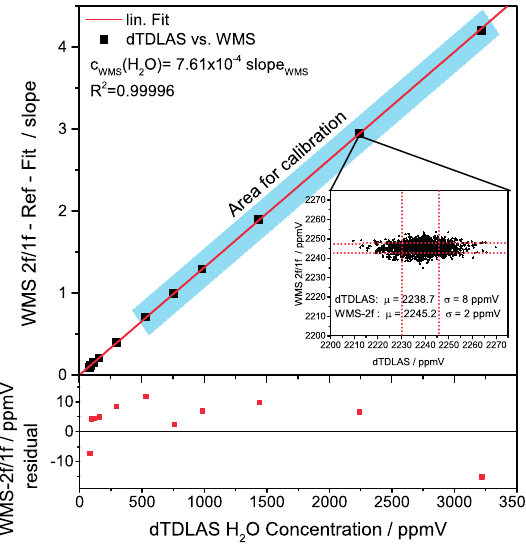
Figure 14. WMS calibration of the normalized WMS 2f/1f measurements against the absolute H 2 O concentration obtained using dTDLAS. The excellent linearity of WMS and dTDLAS measurements results in a R ² of the calibration of 0.99996. The insert shows single scan results over a 30 min long concentration step.